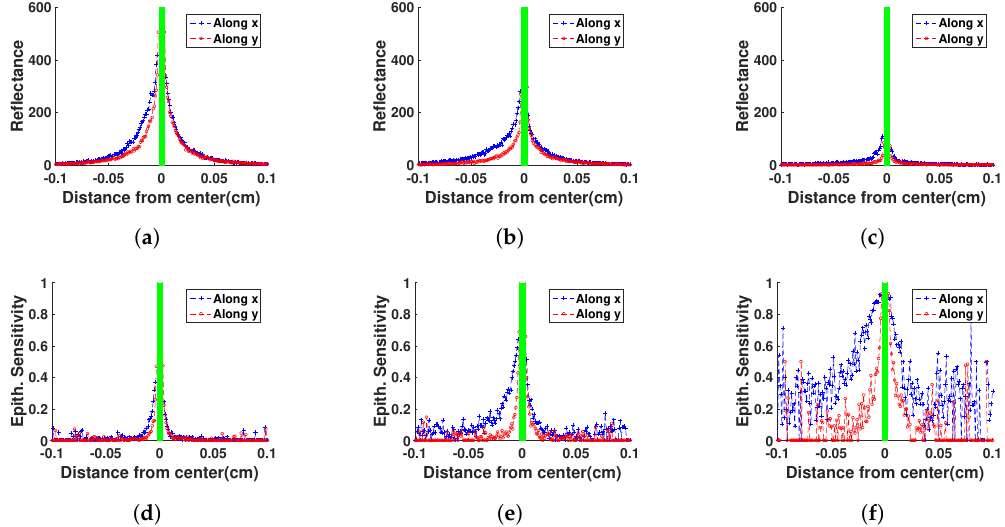
Figure 4. For probe geometry-II and source fiber diameter 50 µ m, the collected SRR along x- and y- axes for bevel angles ( a ) β = 30 ◦ , ( b ) β = 45 ◦ , and ( c ) β = 60 ◦ ,. Corresponding epithelial sensitivity plots for bevel angles ( d ) β = 30 ◦ , ( e ) β = 45 ◦ , and ( f ) β = 60 ◦ . Width of the green region at the center of each of the plots indicates the size of the source (color online